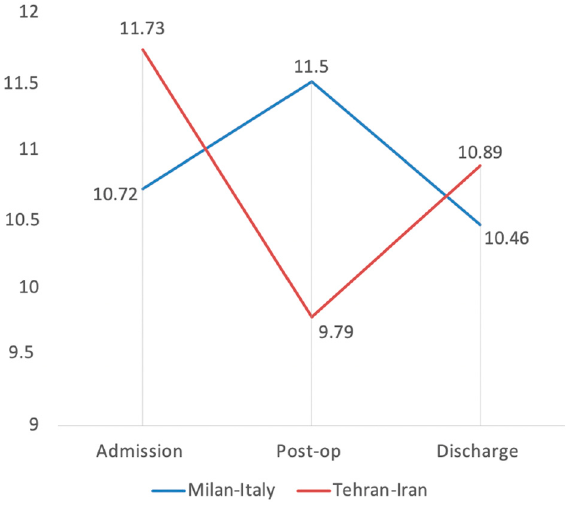
Figure 1. Trend of white blood cells (WBC) in COVID-19 Italian and Iranian groups.